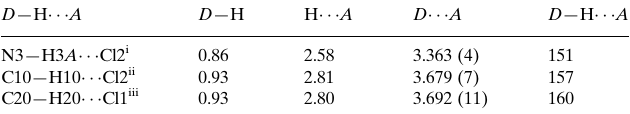
Hydrogen-bond geometry (A˚ , (cid:2)